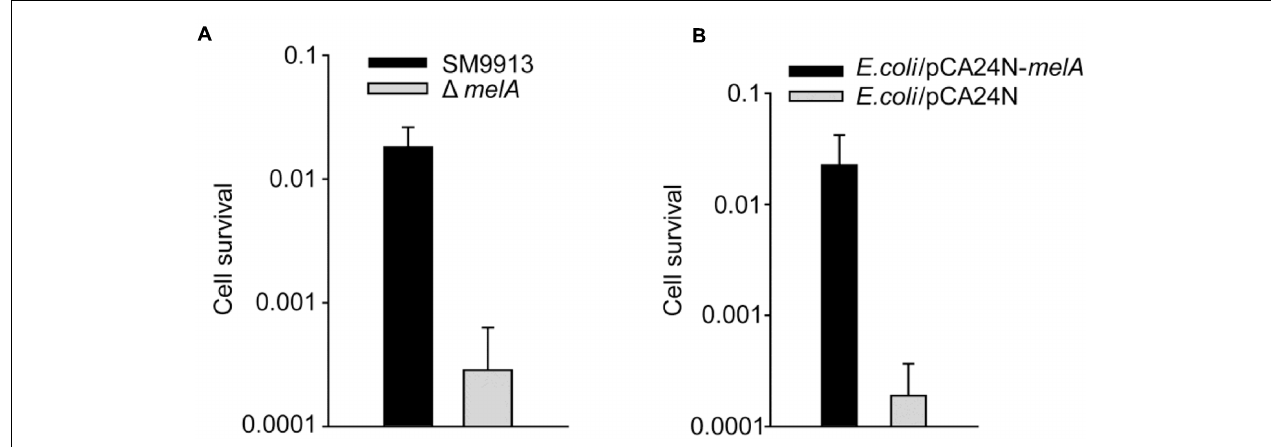
FIGURE 4 | Pyomelanin production requires melA and the melA product increases temperature tolerance. (A) The cell viability of SM9913 and (cid:49) melA strains after heat stress of 45 ◦ C for 30 min. (B) The cell viability of Escherichia coli K12/pCA24N- melA and E. coli K12/pCA24N after heat stress of 45 ◦ C for 30 min. Expression of melA in E. coli K12 was induced with 0.5 mM IPTG. Data are the average of three independent cultures, and one standard deviation is shown in (A,B)